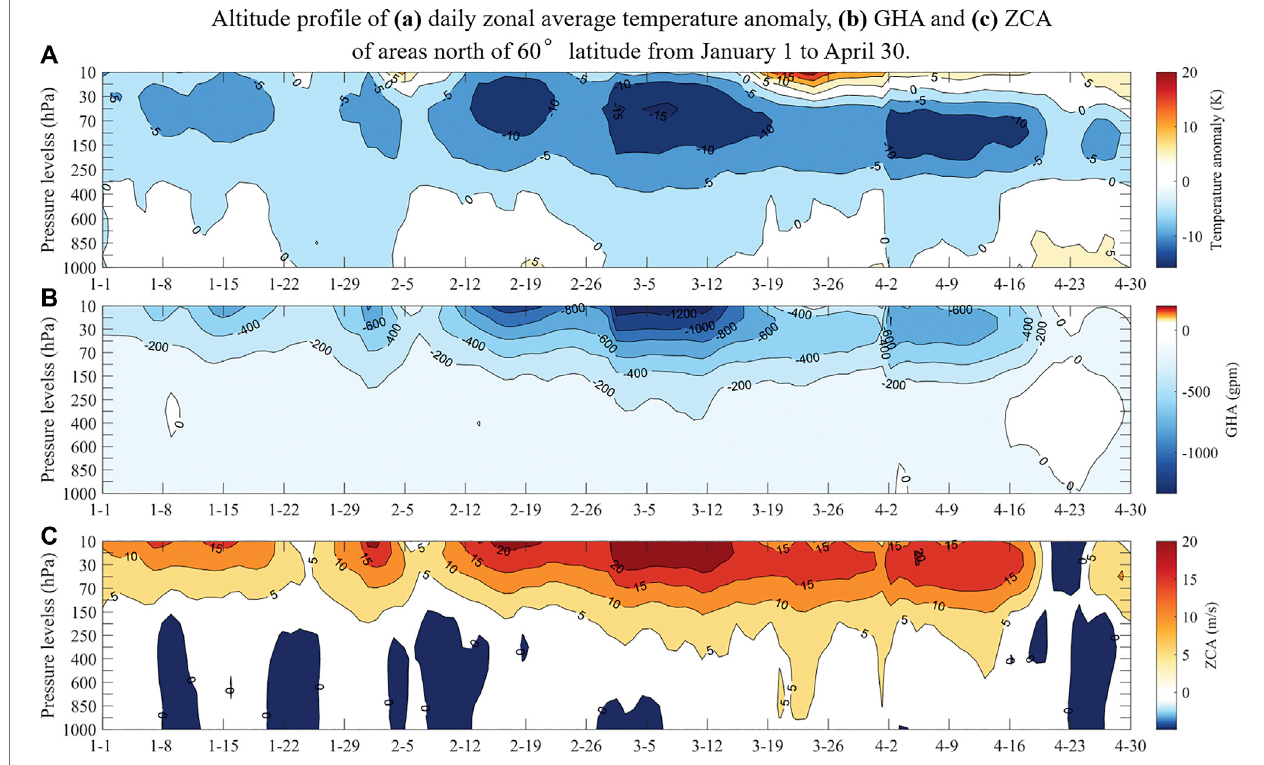
FIGURE 4 | Vertical pro fi les of the (A) daily zonal-average temperature anomaly, (B) GHA, and (C) ZCA for areas north of 60 ° N latitude from January 1 to April 30.